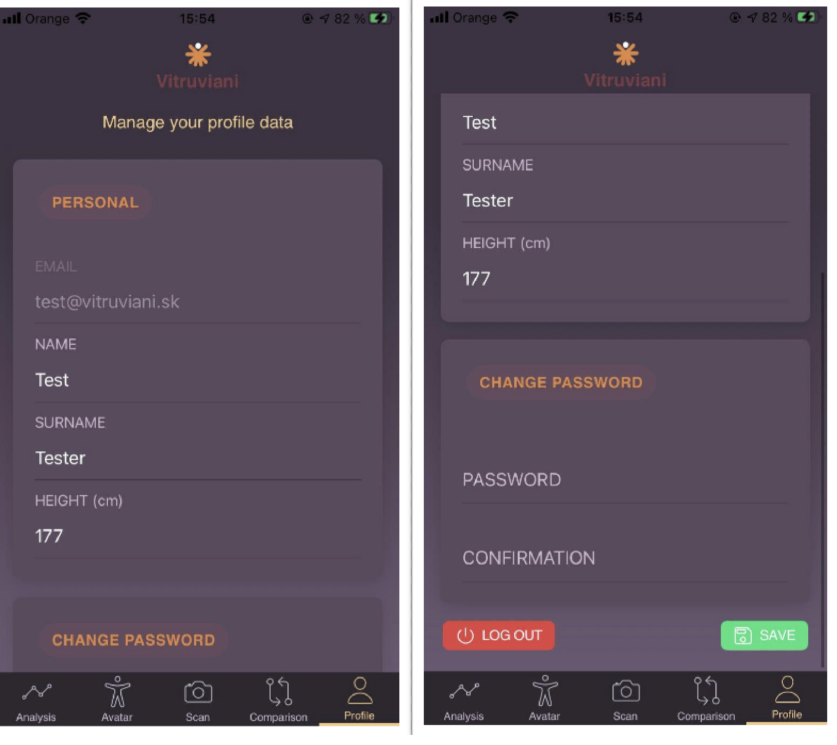
Figure 5. Profile